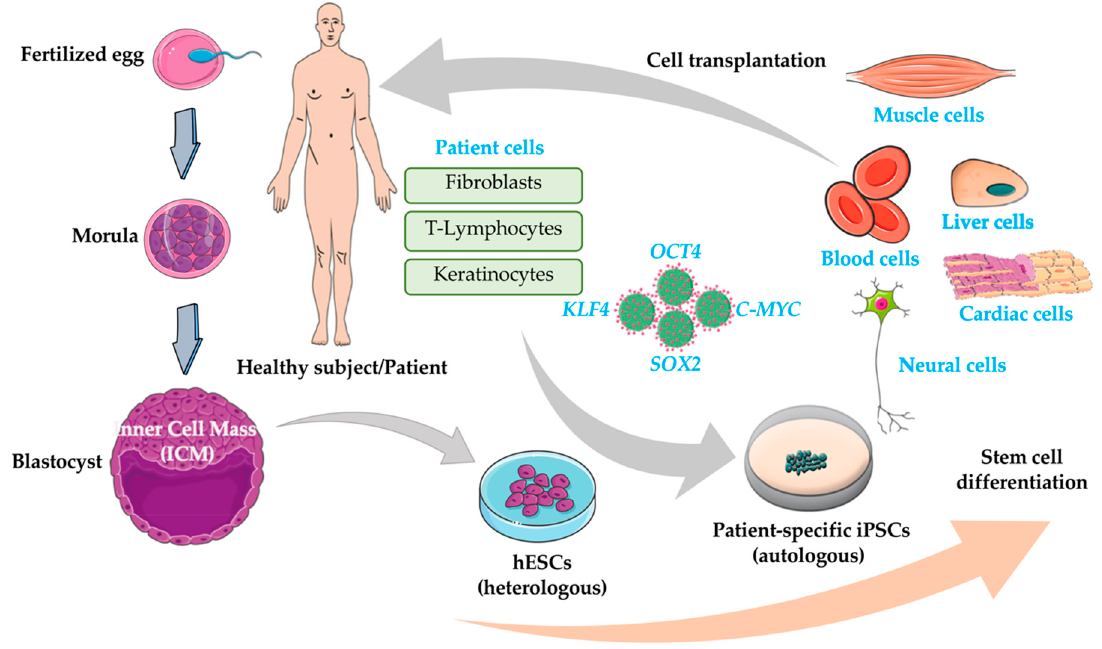
Figure 1. Pluripotent stem cells for cell transplantation therapy.